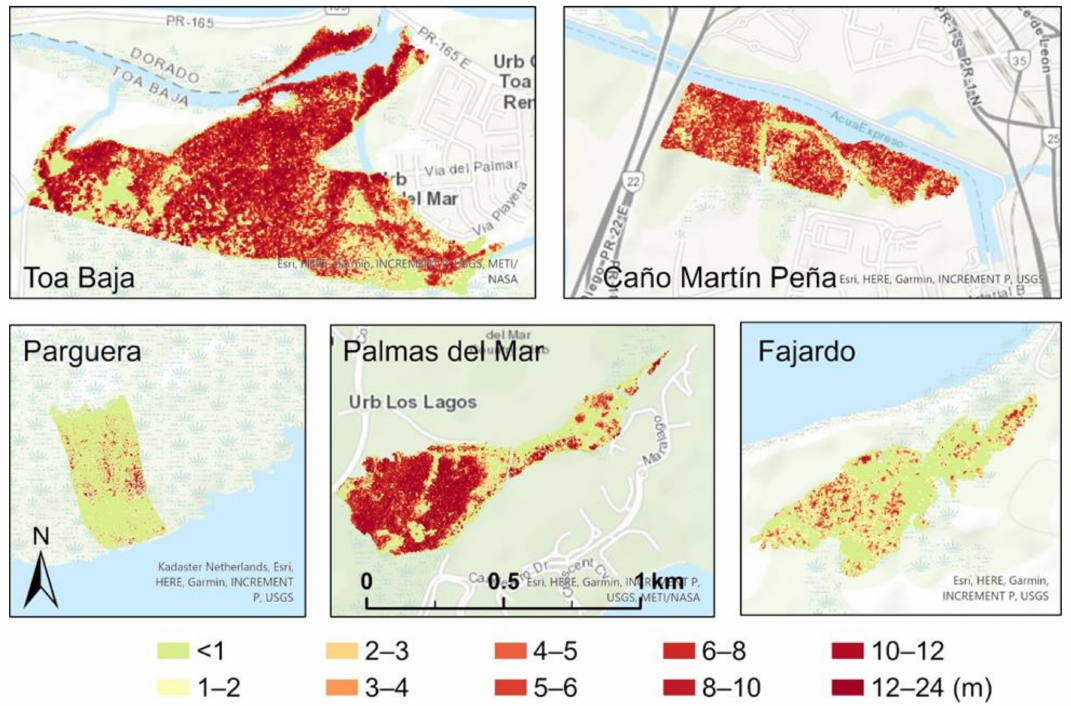
Figure 5. Canopy height reduction calculated as the pre-hurricane canopy height minus the post- hurricane canopy